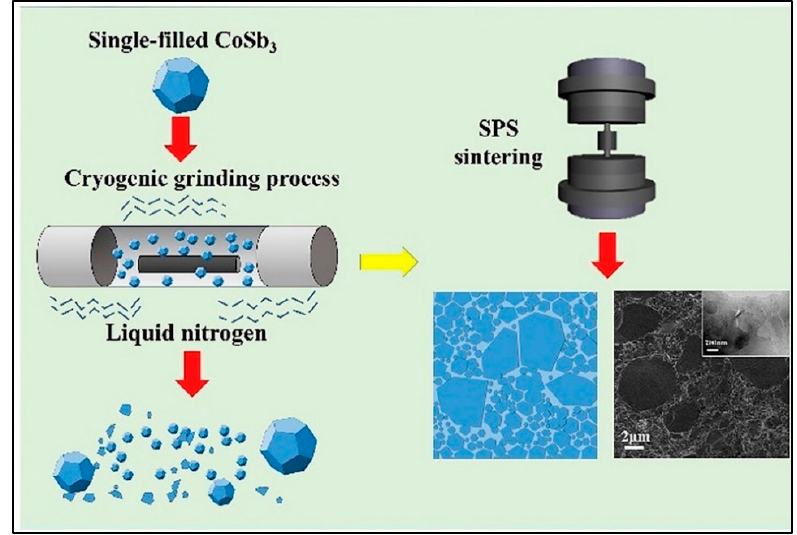
Figure 6. Cryogenic grinding of Yb single-filled CoSb3 into finer particle sizes in the presence of liquid nitrogen. The spark plasma sintering of the powder can also be seen. The SEM image of the material at 2 µm is also included. Reproduced with permission from [18]. Copyright Elsevier, 2019.